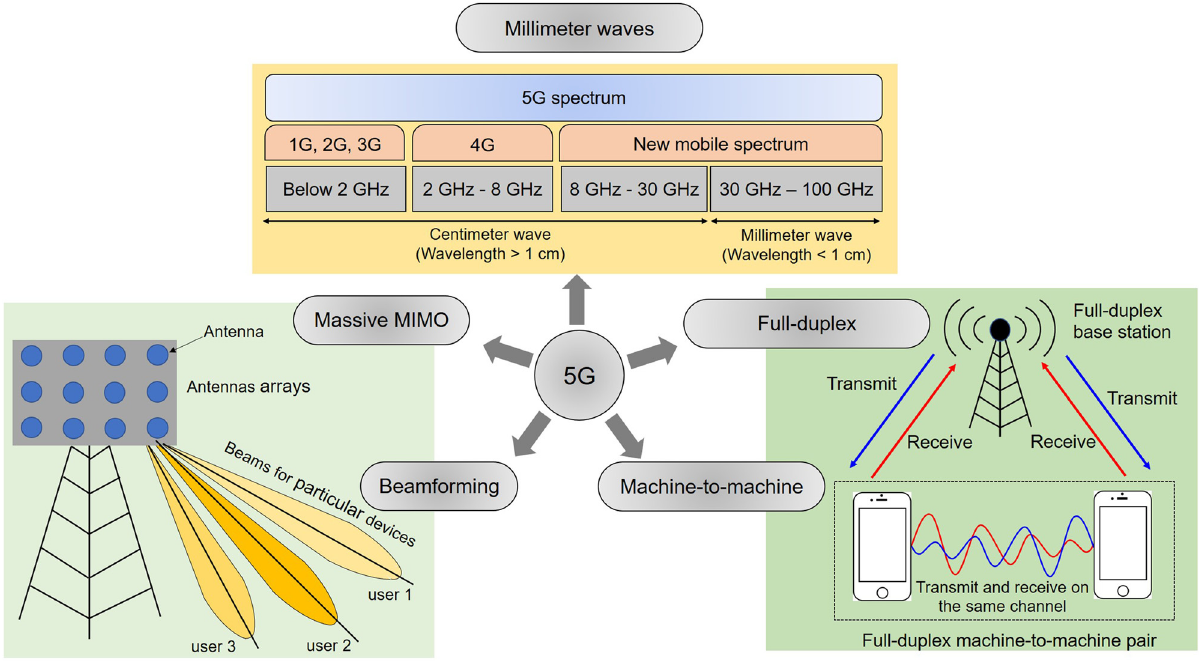
Figure 1: Advanced technologies including millimeter waves, massive MIMO, beamforming, full - duplex, and machine - to - machine applied in 5G wireless communications making it smarter, faster, and more e ffi